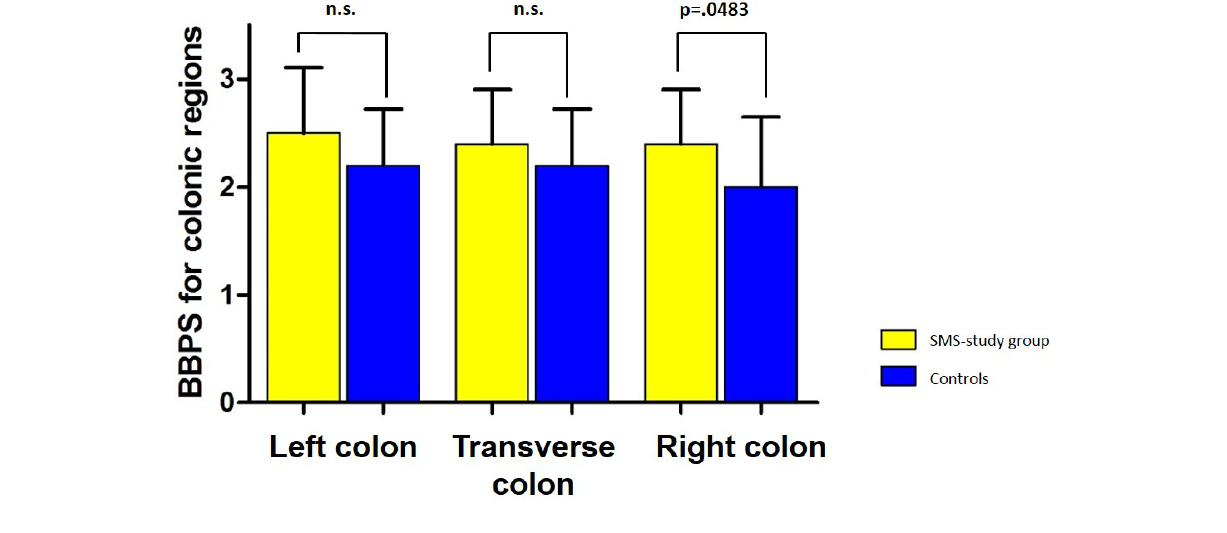
Figure 3. The average Boston Bowel Preparation Scale (BBPS) score (0, minimum to 3, maximum) split for each colon region. SMS: short message service; n.s.: not